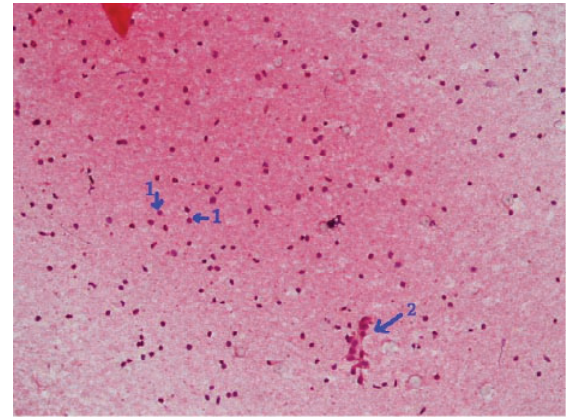
Figure 3. Thyroid fine needle aspiration materials